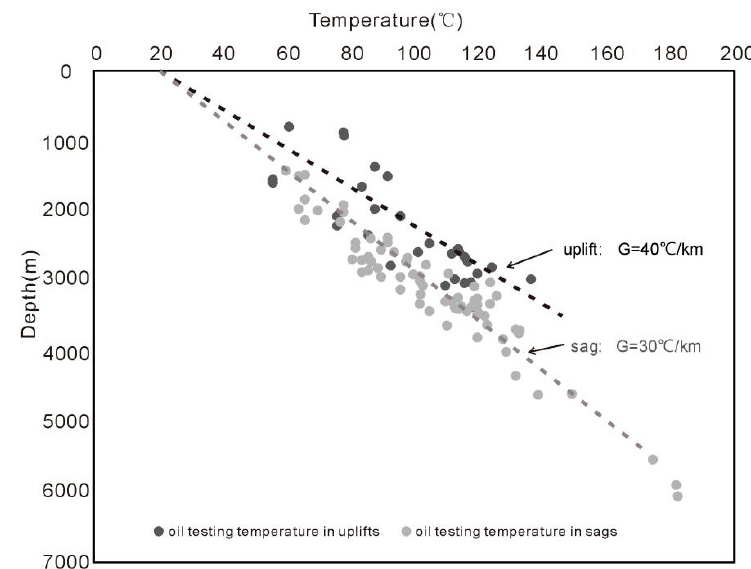
Figure 6. Schematic of the oil-testing temperature data.